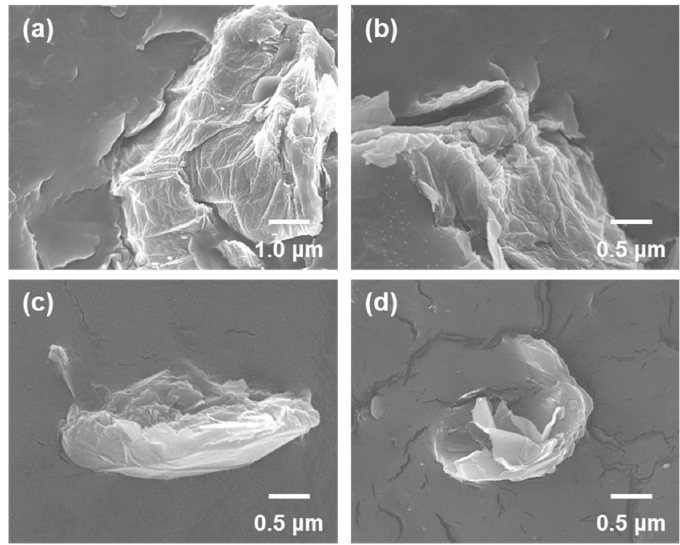
Figure 4. Scanning electron microscopy (SEM) micrographs of the cryofracture of ( a ) PP/GO, ( b ) PP / RGO, ( c ) PP / FGO_6 and ( d ) PP / FGO_12 composites.